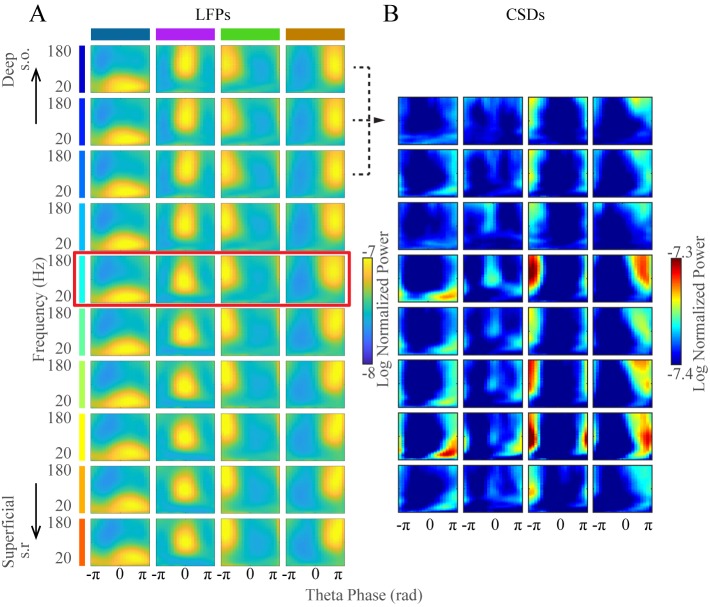
Averaged current source densities across channels for each TG cluster.(A) Average FPP for each cluster for all recording sites from deep to superficial (top to bottom) from the same shank of one probe extracted from all awake periods from one animal (same as Figure 1—figure supplement 2, right). (B) Each cluster’s average current source density (CSD) as a function of frequency and theta phase. Clustering was performed on data from the channel identified as the center of the pyramidal layer (red rectangle in A). Current source densities were calculated over each three adjacent channels (dashed lines) and are shown from from deep to superficial channels (top to bottom). s.o., stratum oriens; s.r., stratum radiatum.